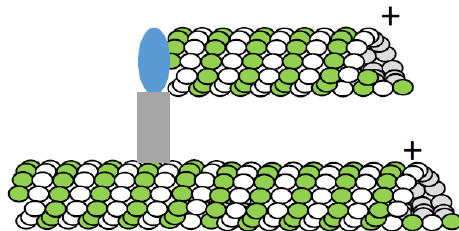
Figure 4. Schematic for microtubule-dependent microtubule formation. The microtubule (tubulin dimer: white, green) can recruit and activate γ-tubulin ring complex (γ-TURC, blue), possibly via the augmin complex (grey).